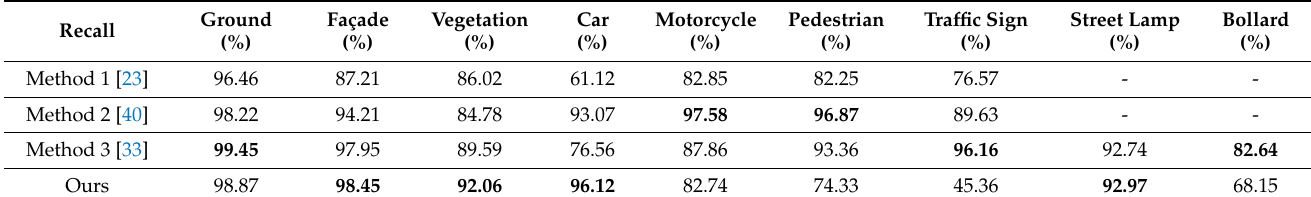
Table 5. Recall of different methods in the Paris-rue-Cassette dataset.